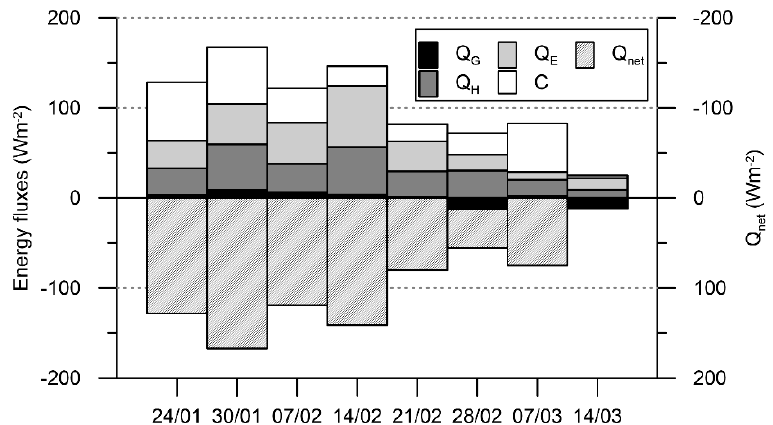
Figure A1. Weekly averages of net radiation (Q net ), ground heat flux (Q G ), sensible heat flux (Q H ), latent heat flux (Q E ) and residual term